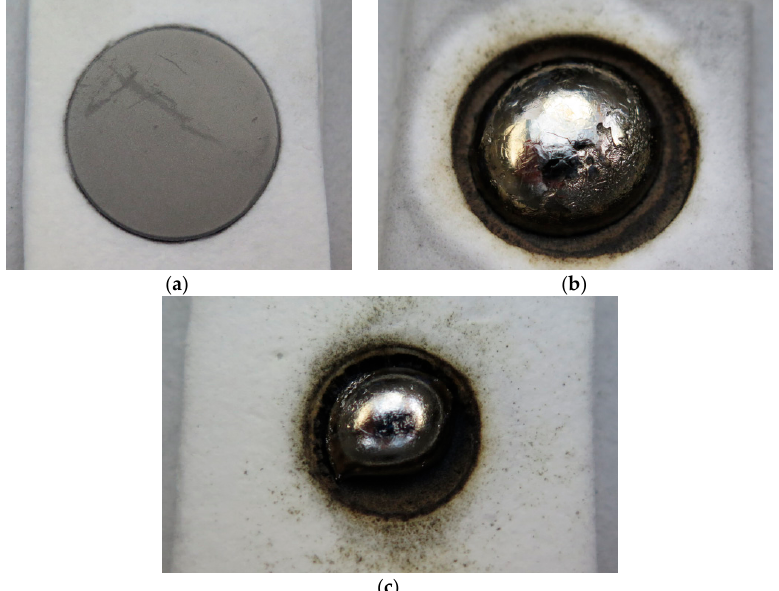
Figure 3. Titanium samples on/in yttria ‐ stabilized zirconia mat: ( a ) Large green compact with diameter of 29.2 mm and height of 5.2 mm prior to solar melting; ( b ) large droplet after solar melting and ( c ) small droplet after solar melting.